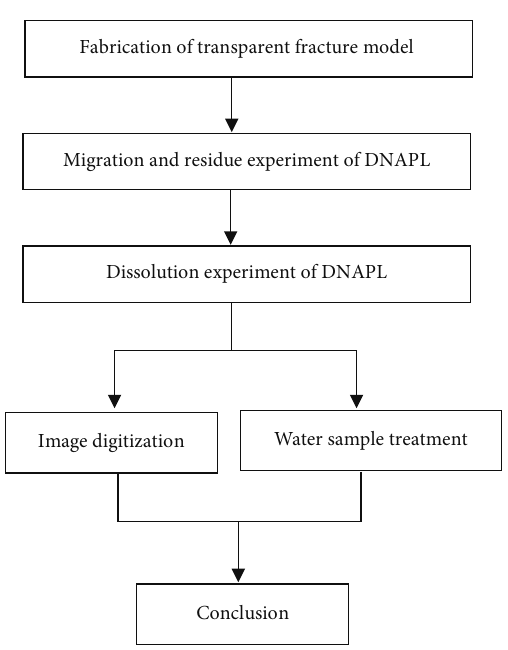
Figure 2: Flowchart of the experiment